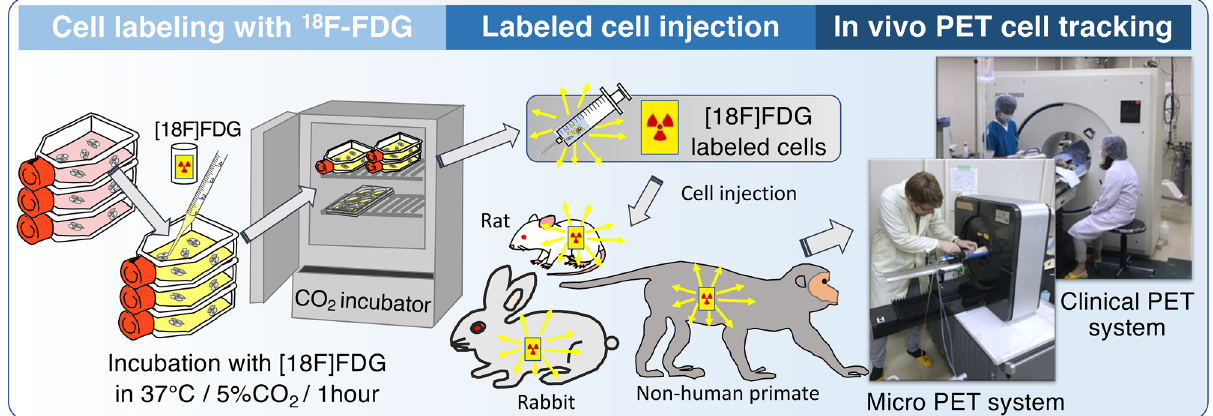
Figure 1. Schematic presentation of the imaging experiment procedure of cell radiolabelling, cell injection, and PET